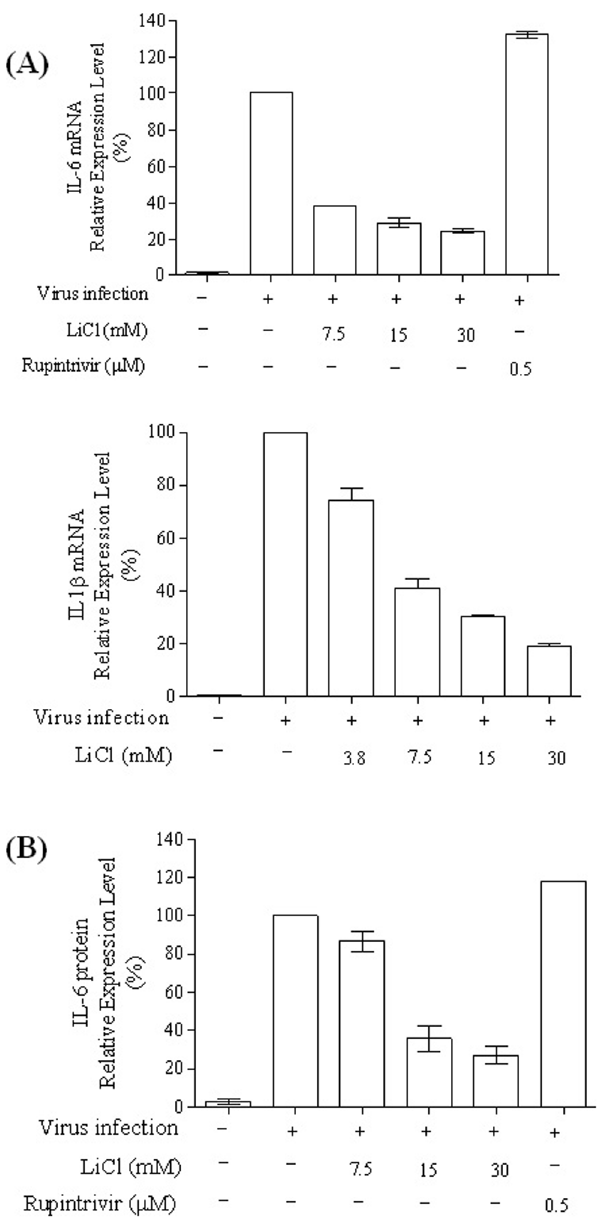
Figure 3. LiCl suppresses pro-inflammatory IL-6 and IL-1 b mRNA expression (A) and IL-6 protein expression (B) in EV- A71-infected SF268 cells. SF268 cells were infected with EV-A71 (moi 0.5), and various concentrations of LiCl were added to the infected cells after viral adsorption time. At 48 h post-infection, the cell lysates were collected for quantification of the IL-6 and IL-1 b mRNA. In a parallel experiment, the IL-6 protein levels in cell culture supernatant were measured using enzyme-linked immunosorbent assay. Data are the mean 6 s.e.m. from at least three parallel measurements per